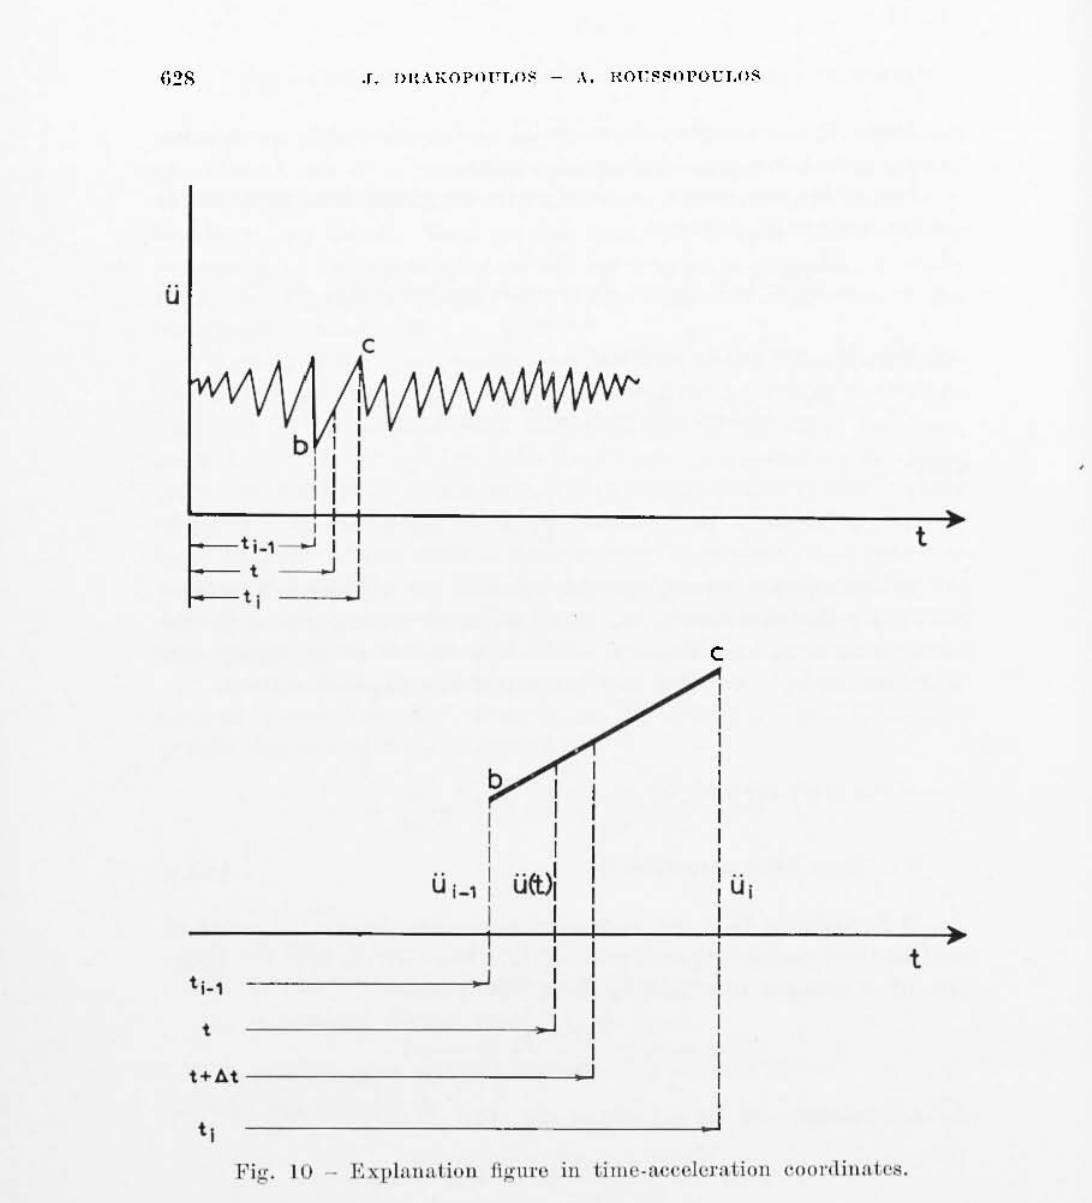
Fig. IO - EXl'lalial iuli fi)!\ll"e in tilllc-ac,·cl<.:l"a tioli cO\JI·d illalcs.